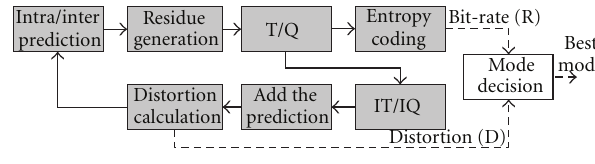
Figure 2: Diagram of RDO-based decision.